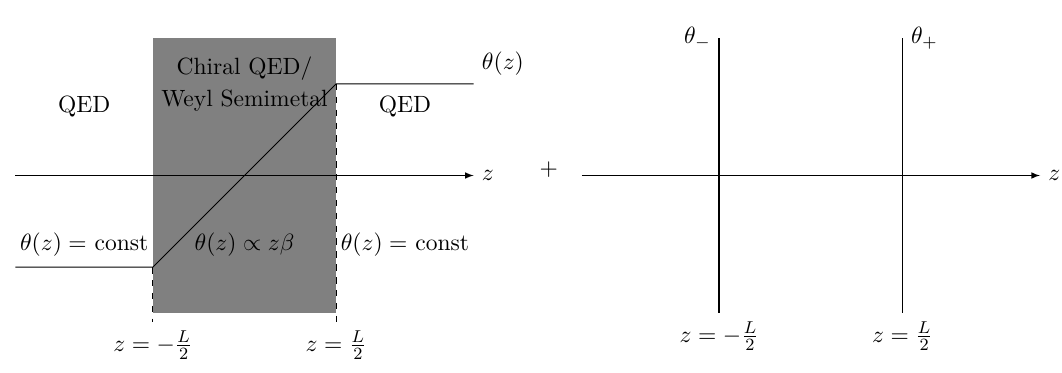
Figure 1 . Our setup, consisting of two parts. On the left the profile of the θ background field is shown, which divides the vacuum into parts where conventional QED and chiral QED, describing a Weyl semimetal, apply. On the right the thin parallel plates are shown, on which PEMC boundary conditions are applied with parameters θ ±